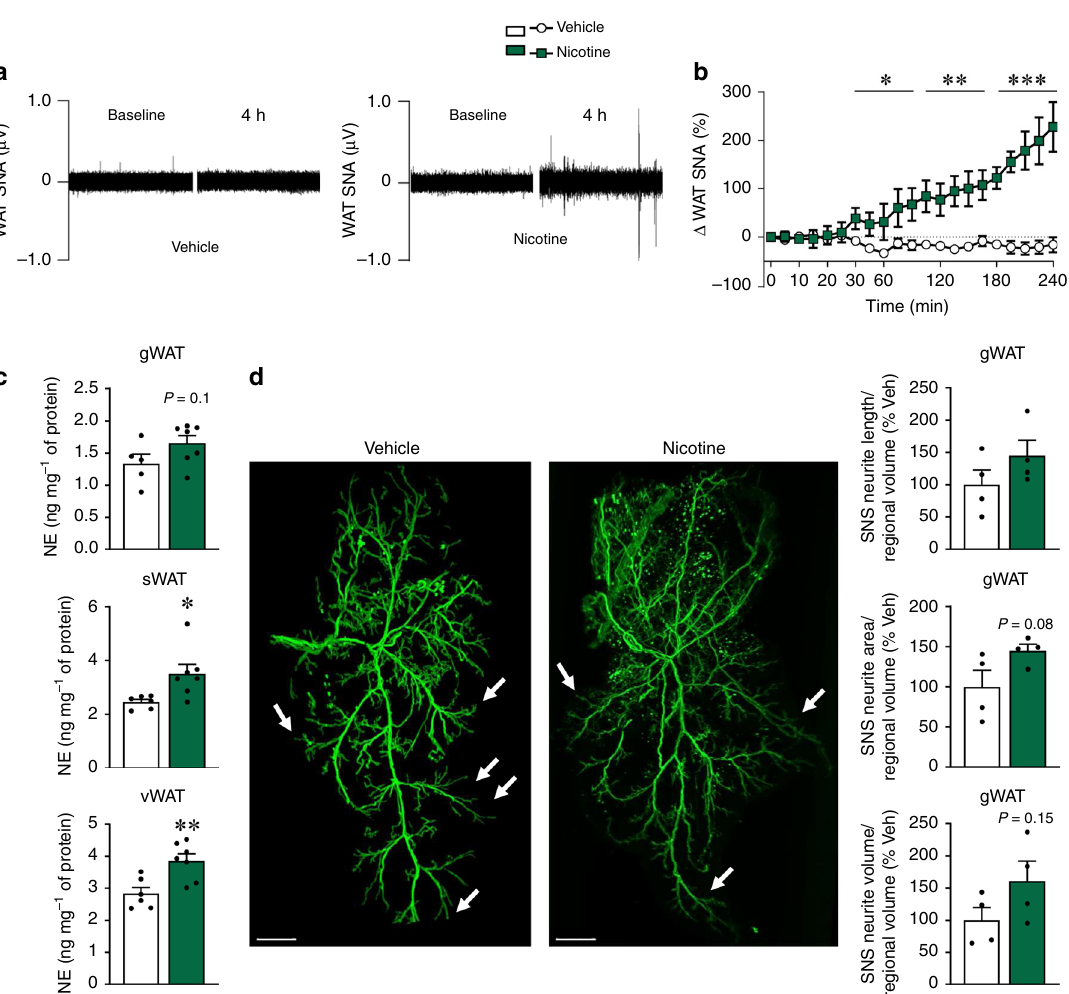
Fig. 2 Effect of central nicotine on SNS. a – b Sympathetic nerve activity (SNA) recorded from the nerves subserving sWAT (vehicle n = 6, nicotine n = 5 mice). c NE levels in gWAT, sWAT, and vWAT (vehicle n = 5, 6, 6, nicotine n = 7, 7, 7 mice). d TH immunohistochemistry (right panel, scale bar: 1000 μ m) and quanti fi cation of SNS neurite length, area and volume (left panel) in gWAT (vehicle n = 4, nicotine n = 4 mice). White arrows represent dendrites of mice treated ICV with vehicle or nicotine. Center values represent average; error bars represent SEM. Statistical signi fi cance was determined by two-sided t -Student; * P < 0.05, ** P < 0.01, *** P < 0.001 vs. vehicle. Source data are provided as a Source Data fi